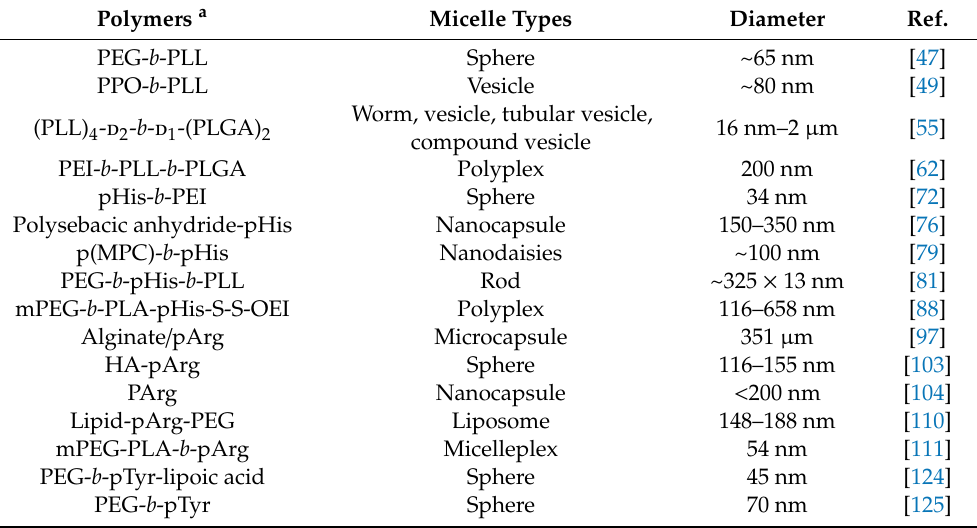
Table 1. Cationic polypeptide based self-assembled